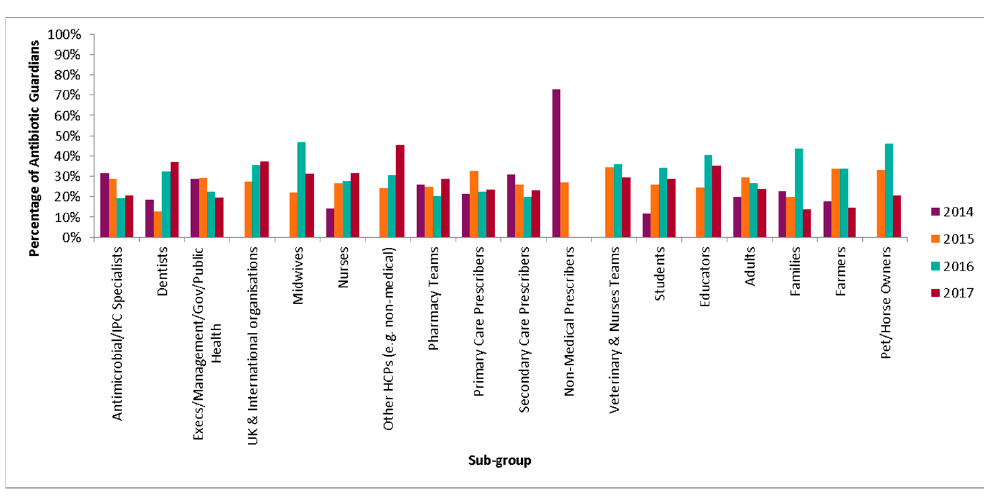
Table 3. Breakdown of student Antibiotic Guardians by study area from 2014–2017 (n = 8826).